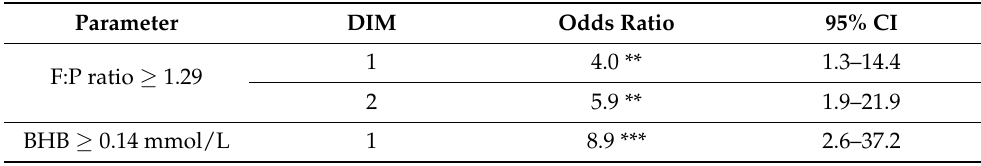
Table 6. The odds ratio for group B to detect cows with fat to protein content ratio (F:P ratio) ≥